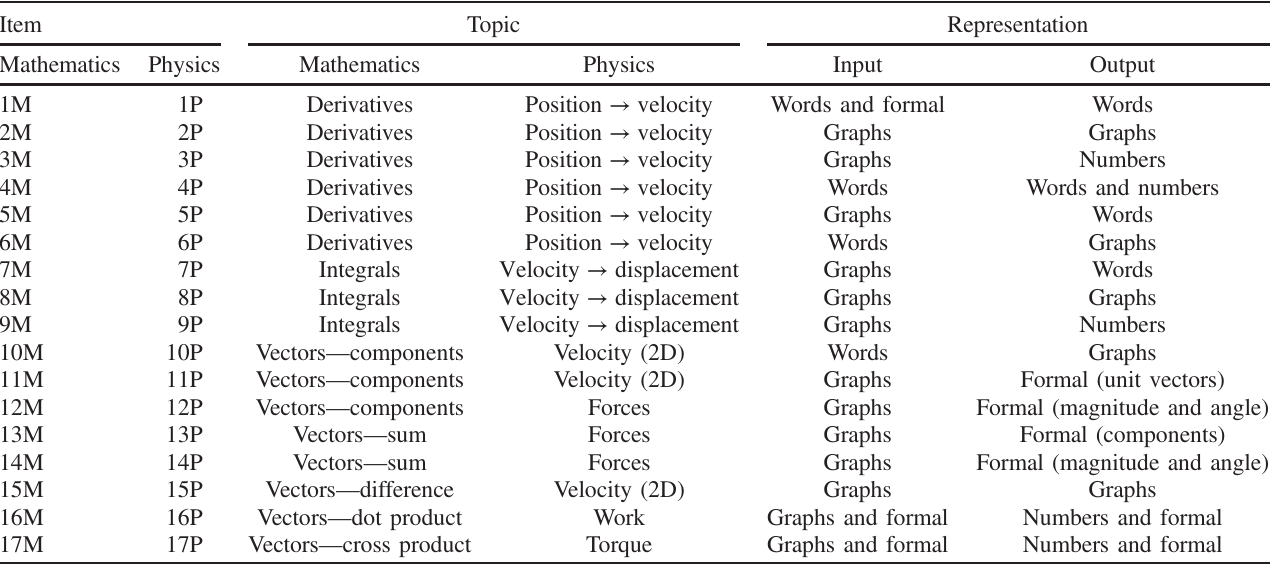
TABLE I. Summary of test